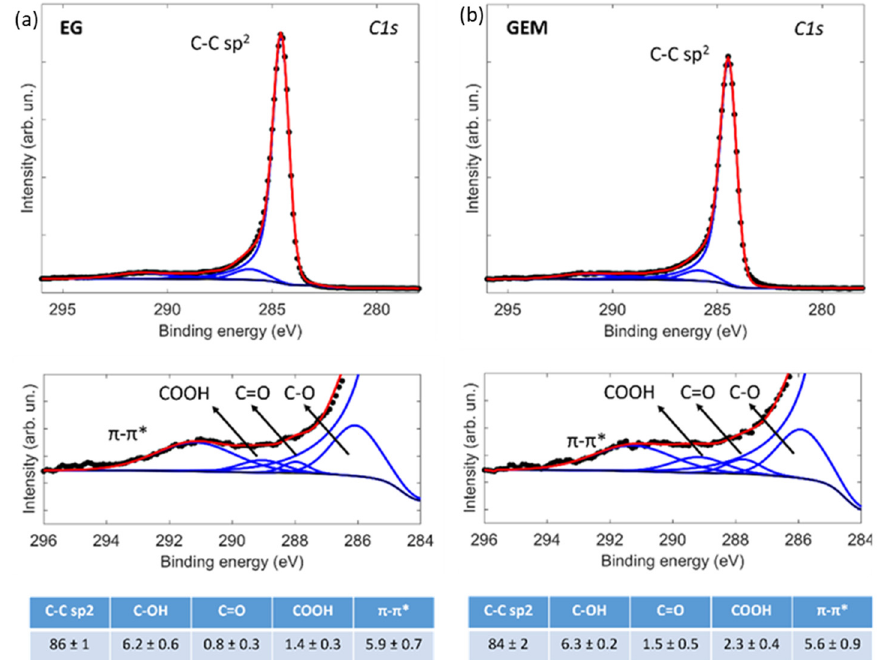
Figure 7. X-ray photoelectron spectroscopy high-resolution scans of the C1s region for exfoliated graphene ( a ) and GEM ( b ) samples, alongside results from fitting with synthetic components. Semi- quantitative results are provided, alongside uncertainties calculated with Monte Carlo routines in CasaXPS software.